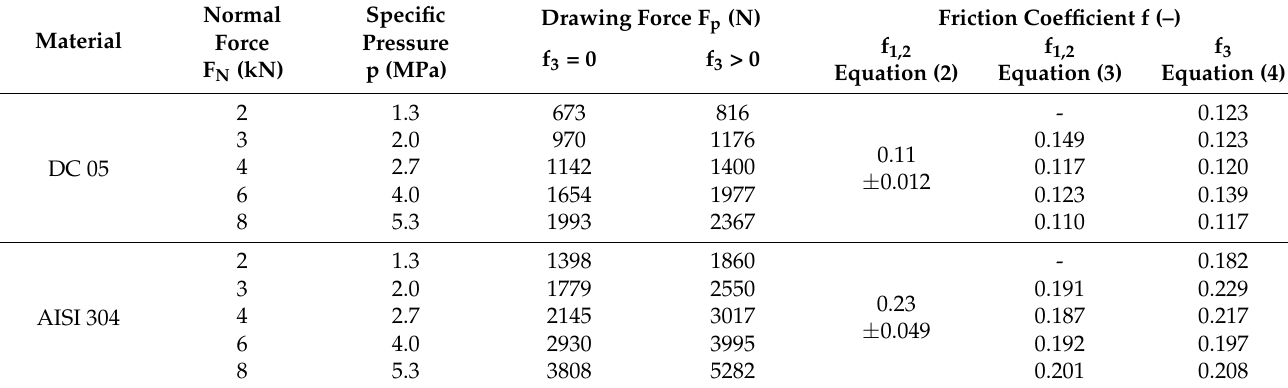
Figure 6. Evaluation of the friction coefficient by linear regression. Table 4. Measured values of forces and calculated values of friction coefficient.